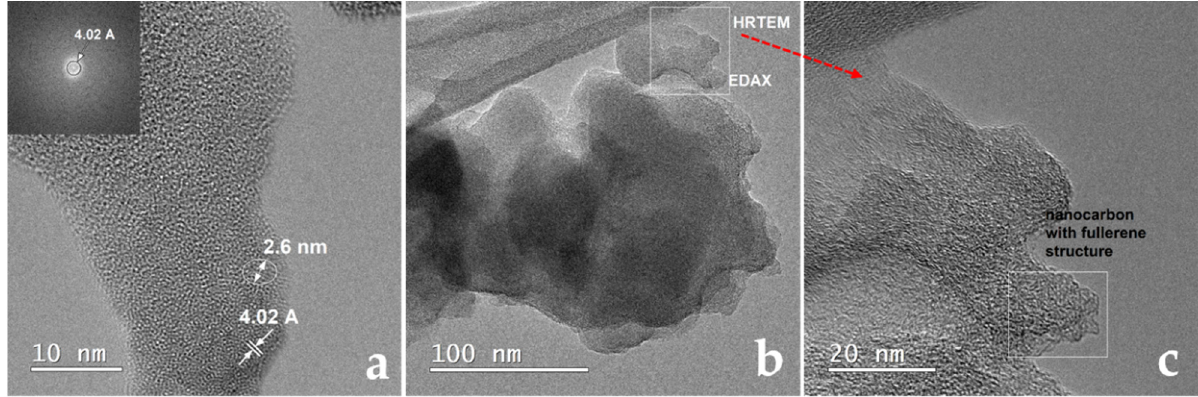
Figure 4. HRTEM image for the ( a ) SiO 2 ; TEM image for the ( b ) C/SiO 2 —0.04 M at low magnification; ( c ) HRTEM image for the C/SiO 2 -0.04 M.